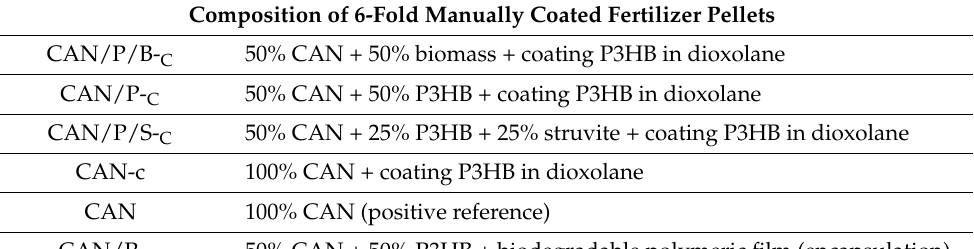
Table 6. The composition of six-fold manually coated fertilizer formulations prepared on a hydraulic press and tested in the aqueous medium.